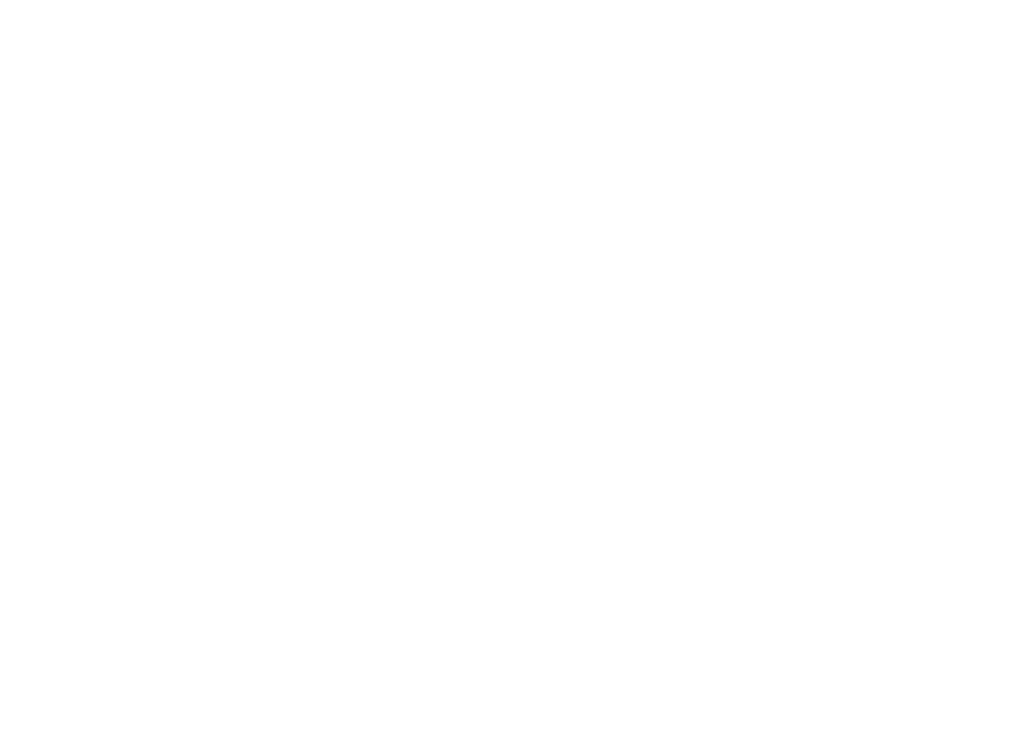
Frontiers in Oncology |